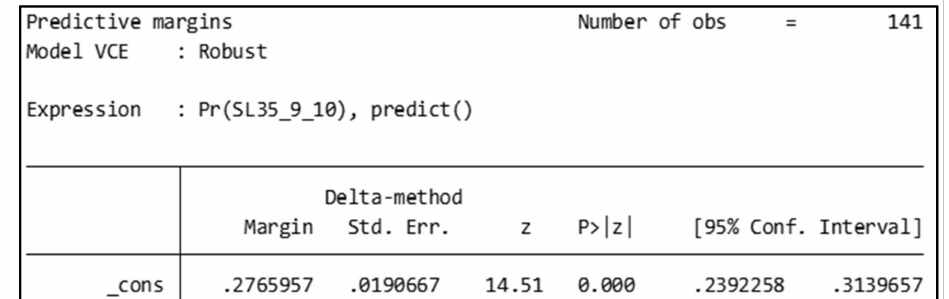
Figure 2. Predictive margins of model